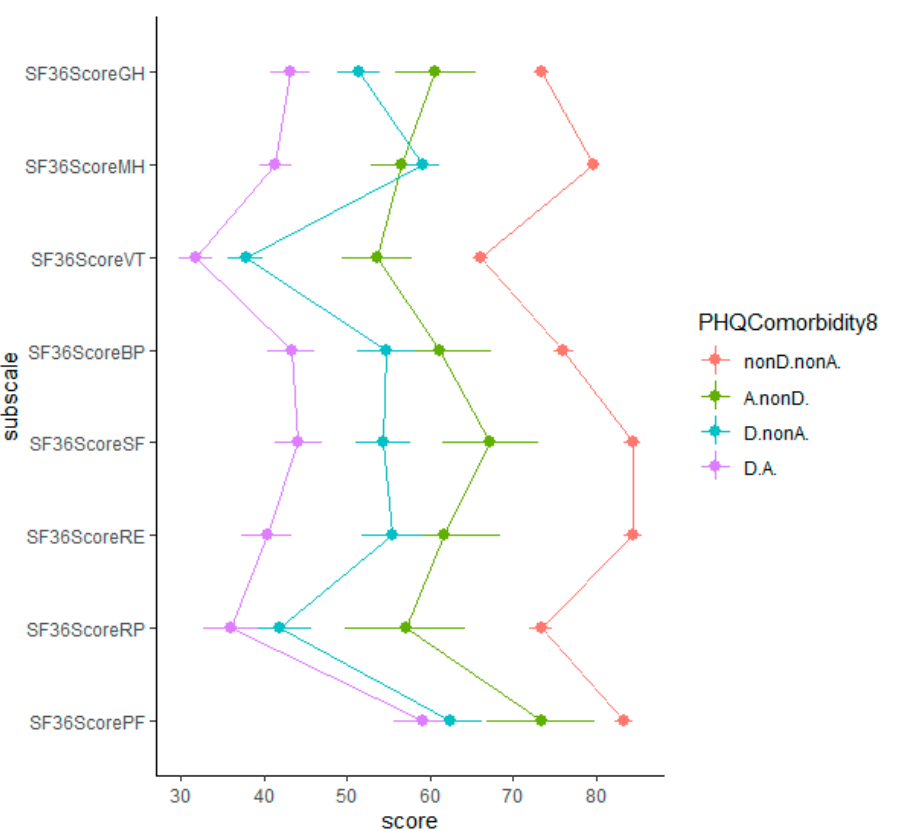
Figure 1. The association of depression and anxiety with physical and mental component scores from the SF-36v2. Note: PF = Physical Functioning; RP = Role Limitation due to Physical Health; RE = Role Limitation due to Emotional Health; SF = Social Functioning; BP = Body Pain; VT = Vitality; MH = Mental Health; GH = General Health; nonD.nonA. = neither depression nor anxiety; A.nonD. = only anxiety; D.nonA. = only depression; D.A. = comorbid depression and anxiety; with the use of cut-off point of 8 for PHQ-9 and GAD-7; the error bar represents the 95% confidence interval.